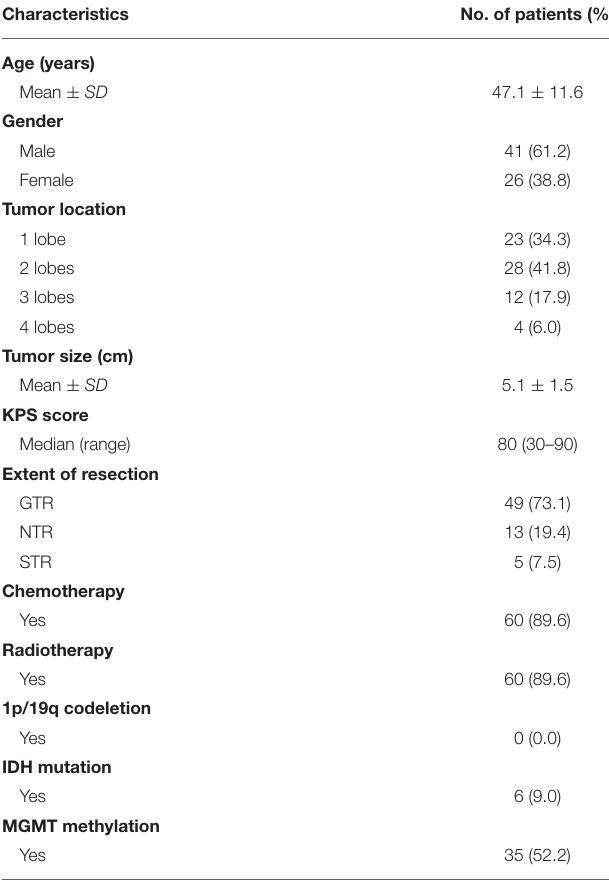
TABLE 1 | Baseline characteristics for all patients with GBM.